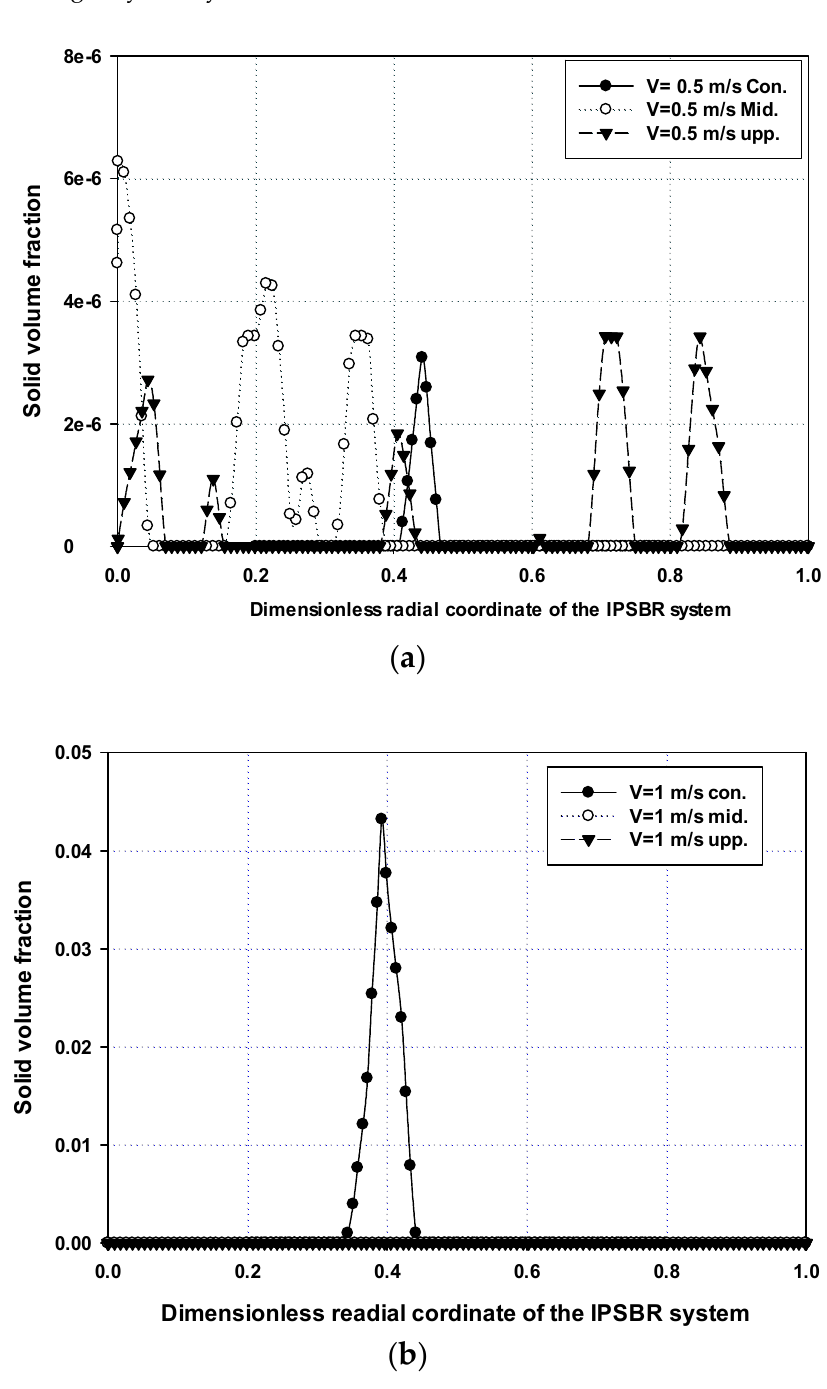
Figure 5. Effect of feed gas velocity (( a ) 0.5 m/s and ( b ) 1.0 m/s) on the average solid volume fraction